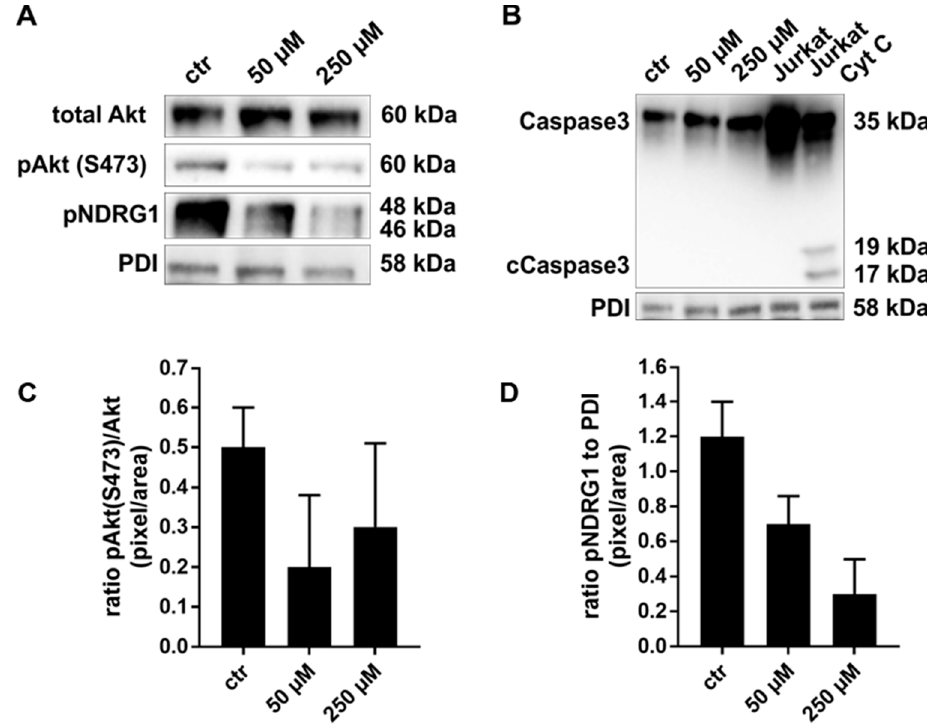
Figure 2. JR-AB2-011 addressed the mTORC2 specific Akt and NDRG1 signaling. Representative Western Blot analysis of total Akt (60 kDa), pAkt Ser473 (60 kDa), and pNDRG1 (58 kDa) in human melanoma (MelIm) ( A ) after treatment with 50 µM and 250 µM JR-AB2-011 indicates a dose-dependent reduction in anti-apoptotic Akt signaling in melanoma cells. Representative Western Blot analysis of Caspase 3 (35 kDa) and activated Caspase 3 (cCaspase 3, 17 kDa) indicates no influence of JR-AB2-011 on classical apoptosis in melanoma cells (MelIm) ( B ). Untreated as well as cytochrome c–treated (Cyt c) Jurkat cells were used as negative and positive controls. Densitometry reveals up to 50% reduction of pAkt Ser473 phosphorylation as determined by ratio of pAkt Ser473 /Akt ( C ). Further, phosphorylation of NDRG1 was dose-dependently affected in melanoma cells. Densitometry reveals up to a 62% reduction of NDRG1 phosphorylation ( D ). 20 µg of protein lysates were separated by SDS-PAGE in three independent experiments, displayed are cropped blots; for full gels see Supplementary Data. PDI was used as a loading control.